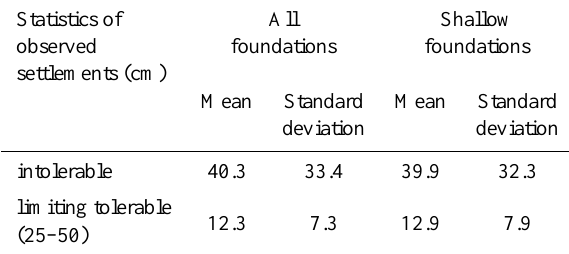
Table 5. Statistics of intolerable and limiting tolerable settlement and angular distortion of buildings (Zhang and Ng,